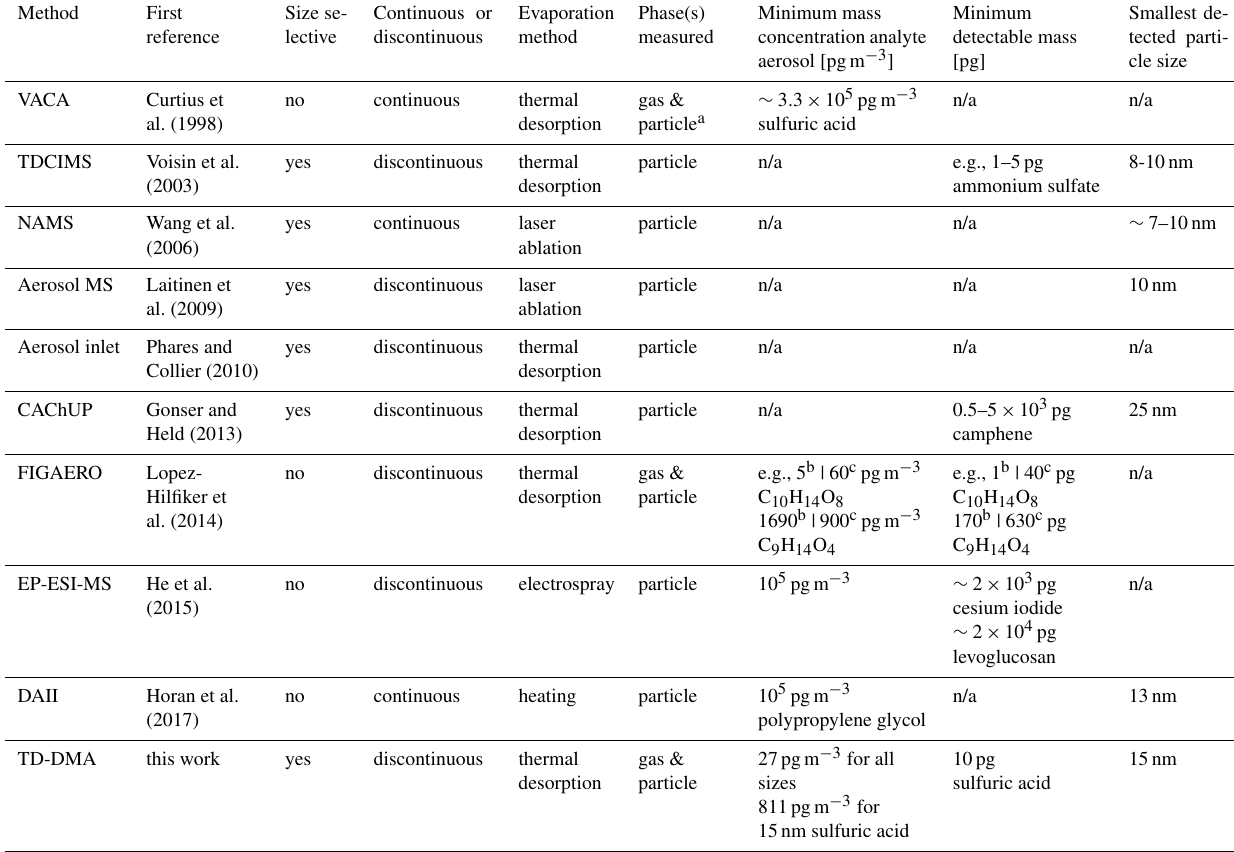
Table 1. Instruments capable of chemical analysis of sub-30nm particles. For interpretation of the parameters, see the discussion Sect. 6.2, and for references to later work on the individual instruments, see the introduction Sect.